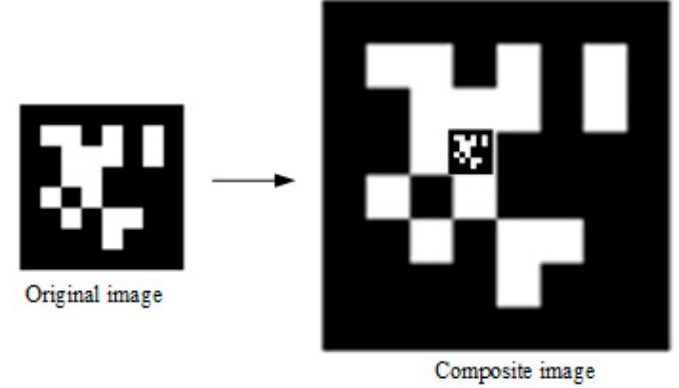
Figure 4. Image label. The image label is composed of a large icon (35 cm × 35 cm) and a small icon (4 cm × 4 cm).